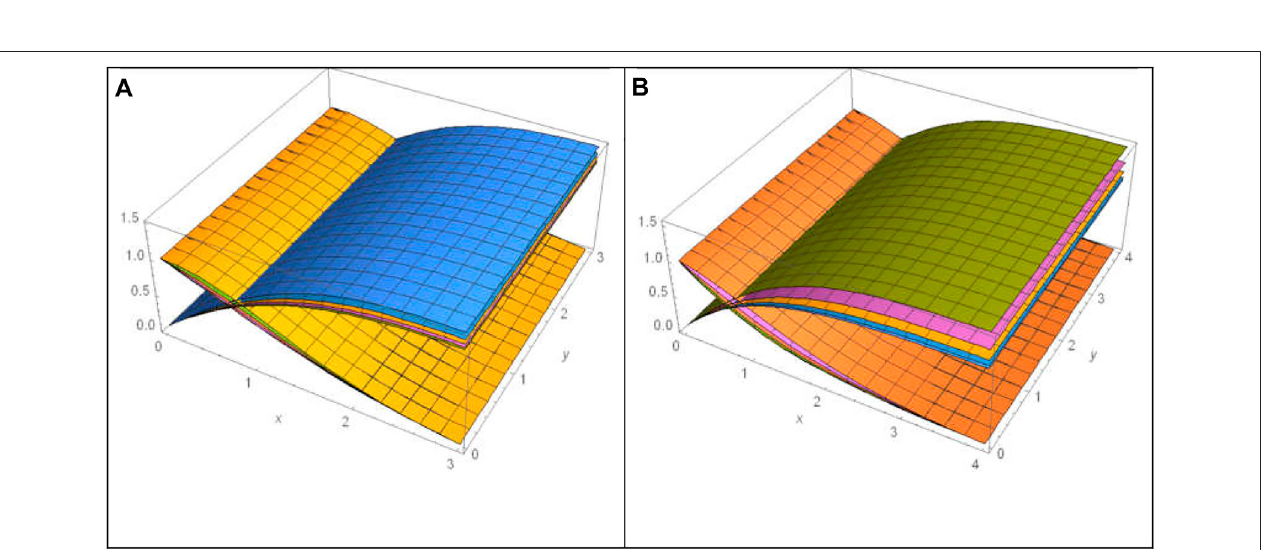
FIGURE 3 | 3D view for (A) m and (B) M on the velocity fi eld.